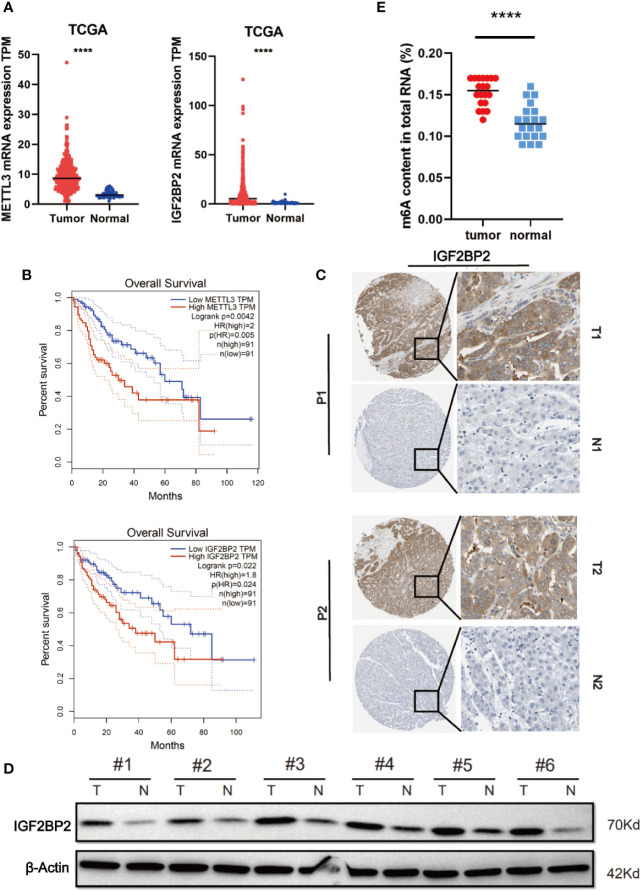
Elevated IGF2BP2 expression correlates with poor prognosis of patients with HCC. (A) METTL3 (left) and IGF2BP2 (right) mRNA levels in the TCGA databases. (B) Kaplan-Meier survival curves of OS based on METTL3 and IGF2BP2 expression using the online bioinformatics tool GEPIA. (C) Representative IHC images of IGF2BP2 protein expression in HCC tissues (T) and adjacent normal tissue (N) of two patients (P1–P2). (D) IGF2BP2 protein levels were measured in HCC tissues and paired normal tissues by western blotting. (E) An m6A RNA methylation assay revealed the m6A content in HCC tissues and adjacent normal tissues. (****P < 0.0001, Student’s t-test).